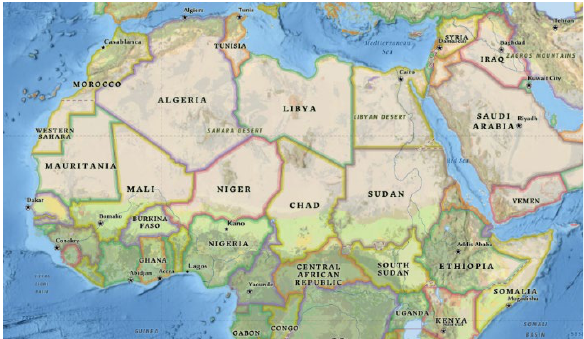
Fig. 1. Study Area Map. Source: National Geographic Style Map, ESRI base